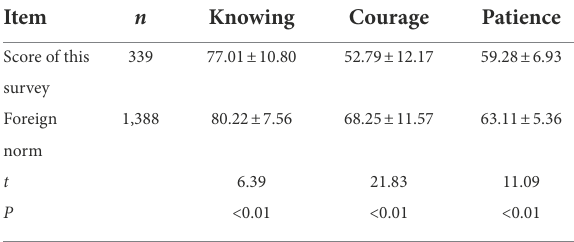
TABLE 1 Comparison of clinical nurse CAI scale scores between nurses included in this study and the foreign